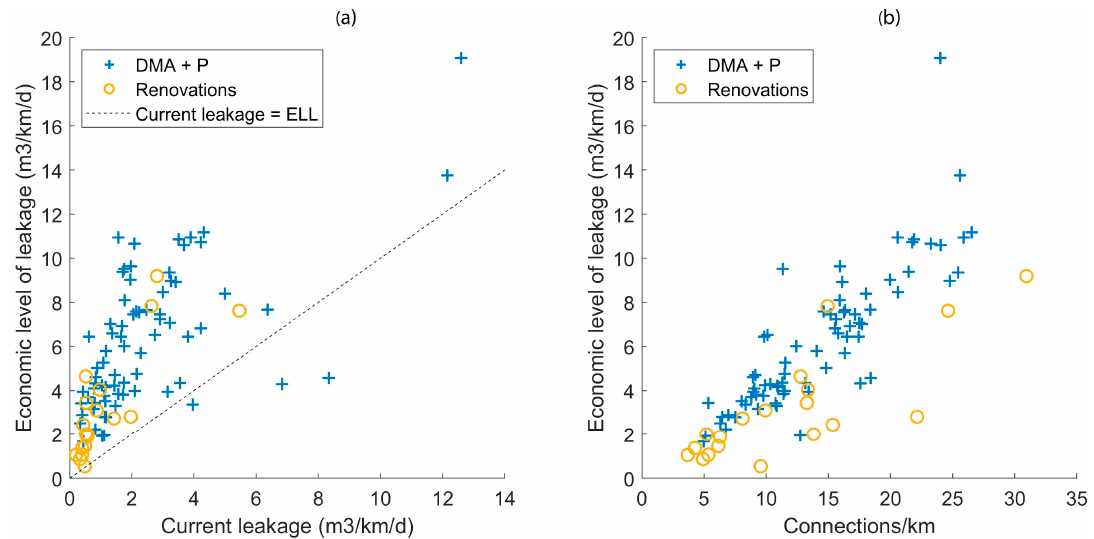
Figure 4. The economic level of leakage in terms of leakage per network length per day for each utility against ( a ) the current leakage level and ( b ) the connection density. The markers show which leakage reduction measure is the most cost-beneficial for each utility.